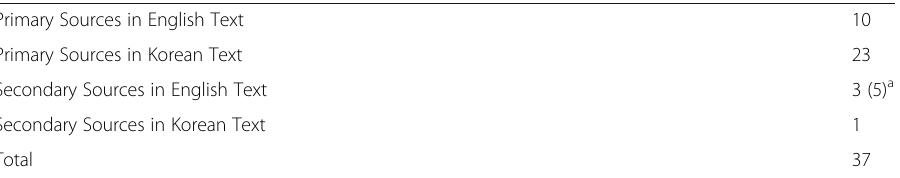
Table 3 Classification of data sources by primary and secondary